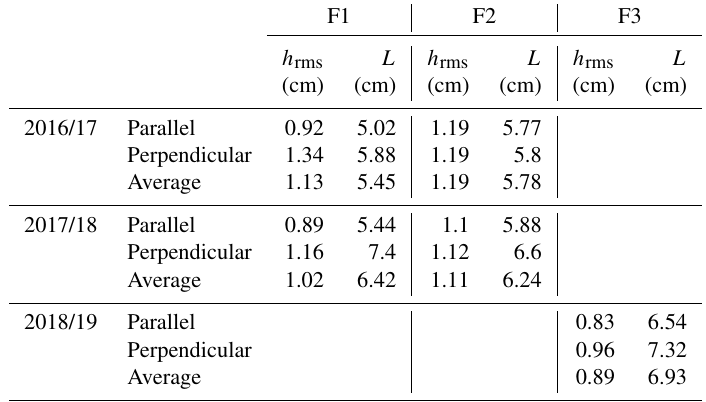
Figure 2. Examples of (a) TDR sensors installed at different depths and (b) a pin profiler picture taken over one of the plowed field with drip irrigation tubes installed. Table 2. Average values of the roughness parameters (eight samples are gathered per field and per